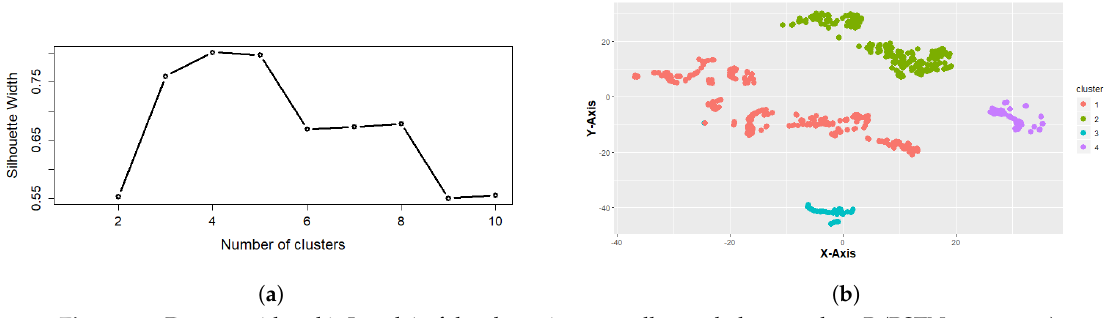
Figure 10. Data considered is Level-1 of the clustering tree, all cases belong to class-B (PSTN customers). ( a ) Curve of average silhouette width to identify optimal number of clusters; ( b ) Plot showing separation of cases with optimal number of clusters identified, four in this case.